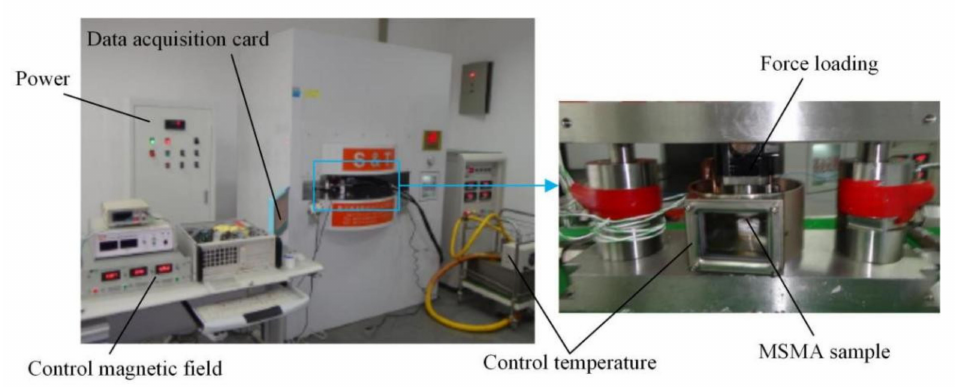
Figure 10. A diagram of the measurement system.